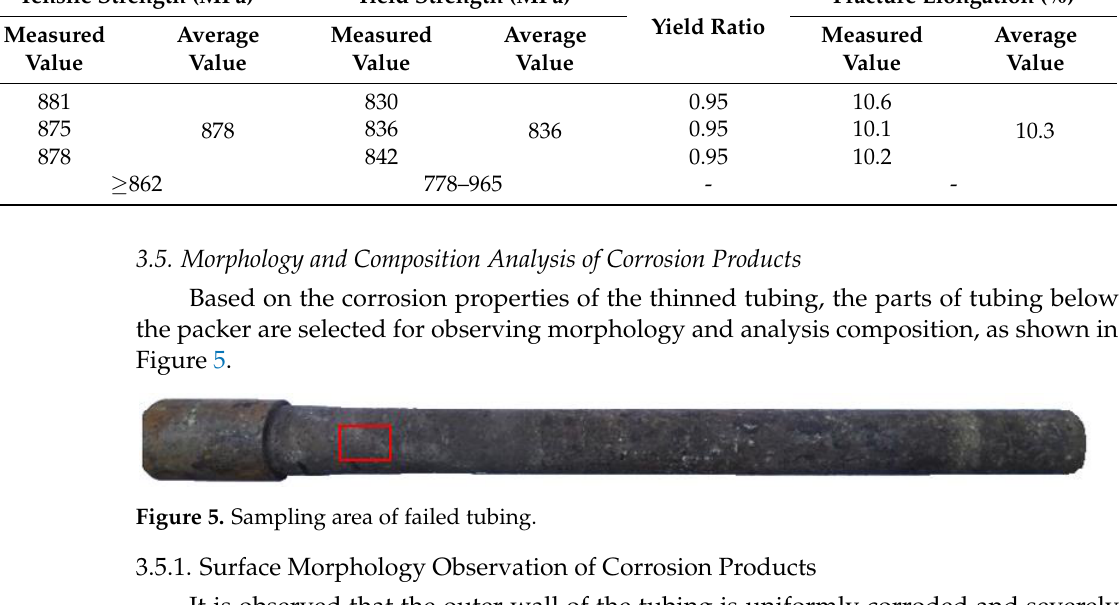
Figure 4. Hardness test results at A1–H3 points.